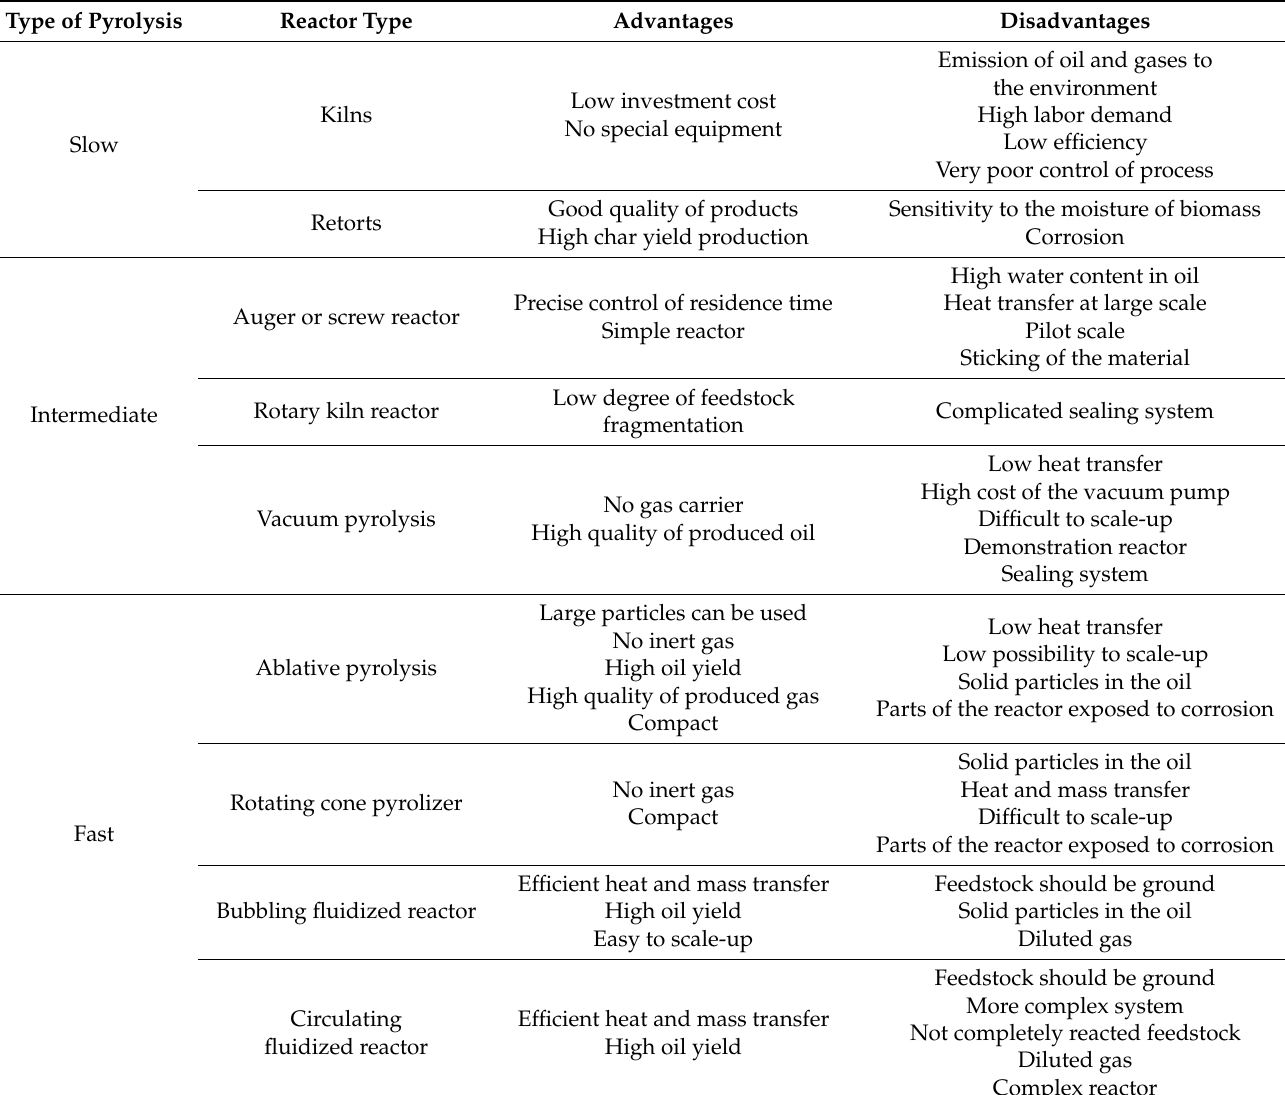
Table 3. Comparison of different types of reactors for